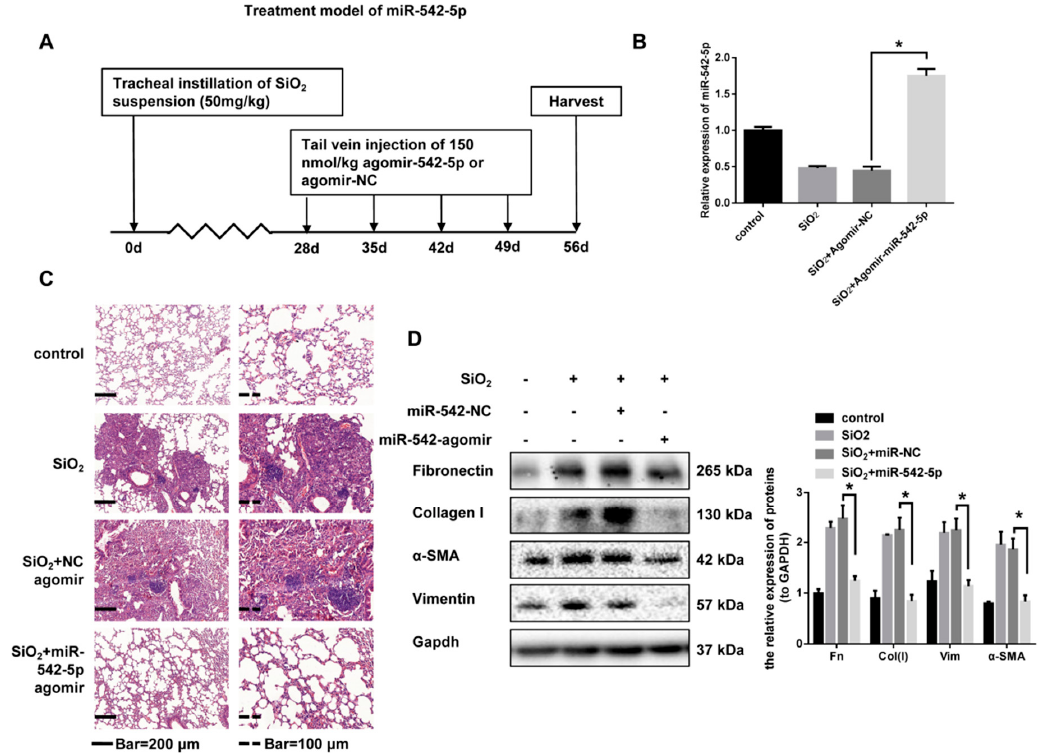
Figure 3. Exogenous miR-542-5p partially reversed silica-induced pulmonary fibrosis in mice. ( A ) The intervention model of miR-542-5p in silica-induced mouse pulmonary fibrosis. The C57BL/6 mice were treated with 50 mg/kg silica suspension via a one-off intratracheal instillation and 140 nmol/kg miR-542-5p agomir or miR-NC agomir was injected to the mouse on days 28, 35, 42 and 49 via the tail vein. Lung tissues were harvested on day 56 ( n = 8 for each group). ( B ) miR-542-5p expression level in silica + miR-542-5p agomir group was significantly increased, compared with the group treated with silica + miR-NC agomir. * p < 0.05 versus the SiO 2 + agomir NC group. ( C ) Hematoxylin and eosin (H&E) staining of mouse lung tissue showed weakened fibrotic lesions compared with the group treated with silica or silica + miR-NC agomir; the most representative results were shown here. ( D ) Expression levels of the fibrosis markers (fibronectin, collagen I, α -SMA and vimentin) of the silica+miR-542-5p agomir group were significantly reversed, compared with the silica + miR-NC agomir group (randomly n = 3 per group). The semi quantification of the protein band was performed by using ImageJ and GAPDH was selected as an internal reference, * p < 0.05 versus the silica + agomir-NC group. Table 2. Therapeutic effect of miR-542-5p agomir administration on lung histopathology. Groups